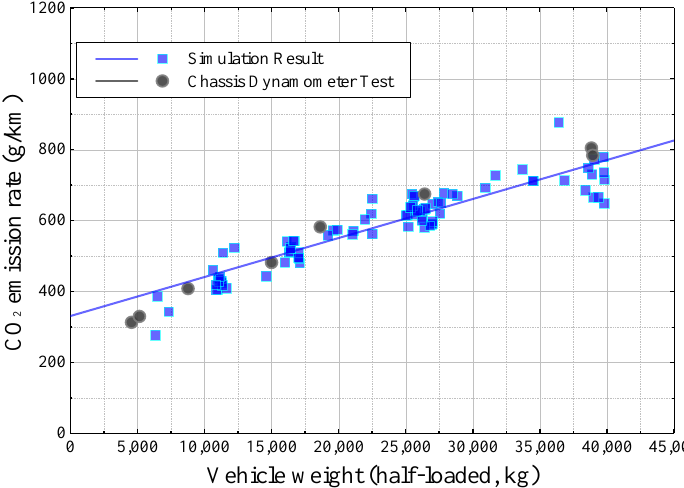
Figure 4. Comparison of the chassis dynamometer test results and the simulation results.